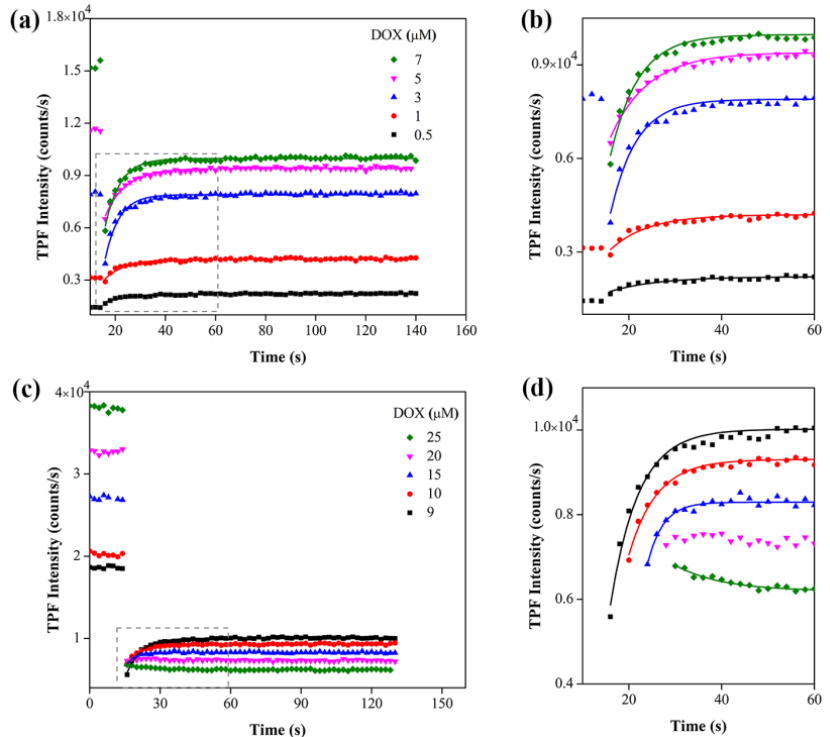
Figure 5. ( a , c ) Time-dependent TPF intensities recorded before and after the addition of DOPG vesicles into DOX solutions at various concentrations. ( b , d ) Magnifications of the rectangle area marked by dotted lines in frames a and c, respectively (some curves were shifted in x direction to make the plot clear). The final concentration of DOPG is 250 µ M. Reproduced with permission [57]. Copyright 2019 American Chemical